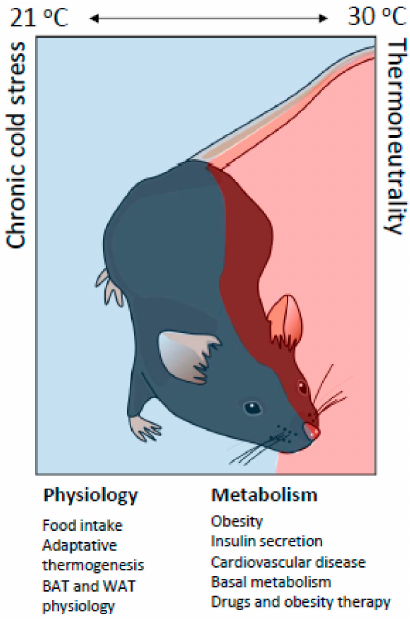
Figure 4. Metabolic and physiological di ff erences in mice under chronic cold or at thermoneutrality. Mouse models used to study metabolic diseases are influenced by environmental temperature. Mice show di ff erences in the metabolic phenotype when housed at a standard temperature (21 ◦ C) vs. thermoneutrality (30 ◦ C). Mice at standard temperatures are subjected to chronic cold. This triggers controlled hypothermia where energy expenditure is a ff ected by changes in physiology (food intake, BAT and WAT physiology and an increase in adaptive thermogenesis) and in metabolism (basal metabolism, adaptive thermogenesis, diet e ffi ciency, insulin secretion, adipose tissue physiology, inflammation at adipocyte and vascular levels, and the e ff ect of drugs and therapies against